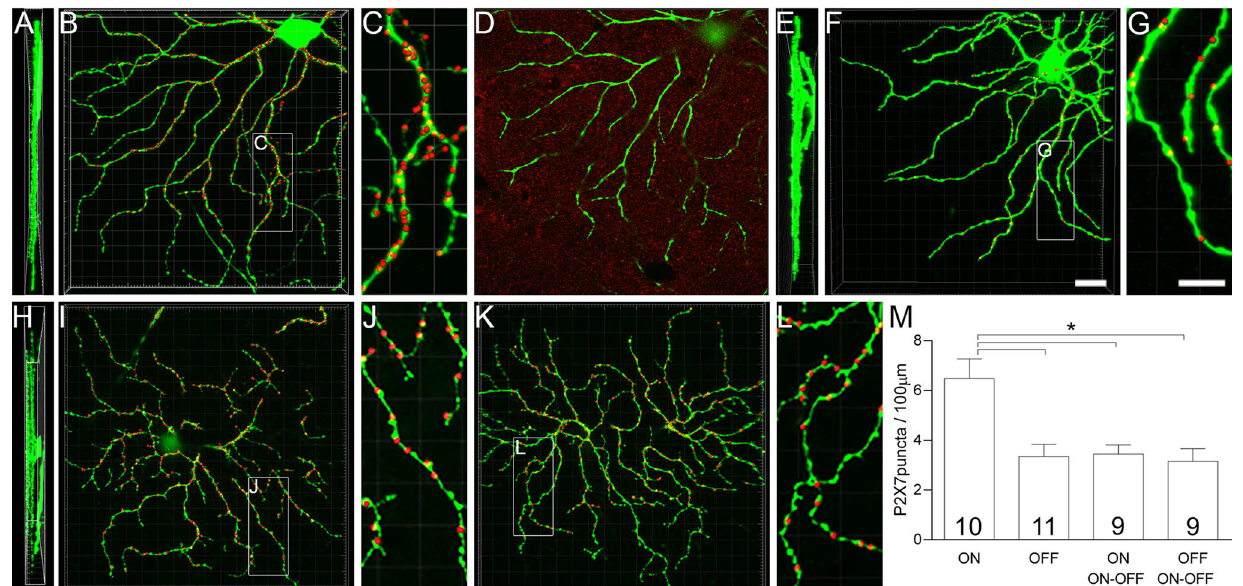
Figure 6. P2X7-Rs are highly expressed in ON-RGCs of Thy1-YFP-H mice. Thy1-YFP-H RGCs (green) are projections of the original confocal Z-stacks, while the P2X7-R puncta contacting the dendrites (red) are digitally rendered as spots (presented as 3 times larger than the true colocalised puncta for ease of viewing). ( A – C ) Thy1-YFP-H labelled ON-RGC (green) showing dense labelling for P2X7-R puncta (red) shown in ( A ) orthogonal view, ( B ) from above and ( C ) magnified inset from ( B ). ( D ) A single plane of raw data from the ON-cell (green) with P2X7-R staining (red). ( E – G ) Thy1-YFP-H labelled OFF-RGC (green) showing sparser labelling for P2X7-R puncta (red) than ON-RGCs. The OFF-RGC is shown in ( E ) orthogonal view, ( F ) from above and ( G ) magnified inset from F . ( H – L ) Thy1-YFP-H labelled ON–OFF RGC (green) in the orthogonal view ( H ) displaying dendritic fields stratifying in ON and OFF sublaminae. Labelling for the P2X7-R puncta (red) in the ON sublamina ( I ) from above and ( J ) magnified inset from ( I ). Labelling for the P2X7-R puncta (red) in the OFF sublamina ( K ) from above and ( L ) magnified inset from K. ( M ) Quantification of P2X7-R puncta in the ON and OFF lamina of the IPL for ON-, OFF- and ON–OFF RGCs. Numbers indicate number of cells from 4 animals. * p < 0.01; one-way ANOVA, Tukey’s multiple comparisons test. Scale bar is 10